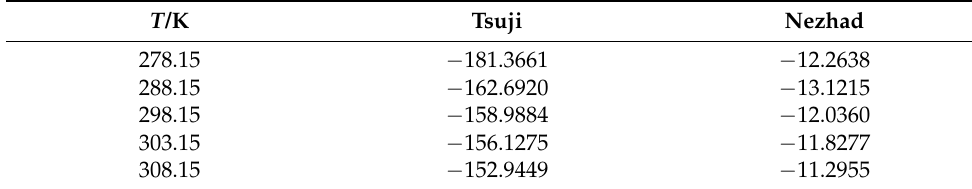
Table 10. Calculation results of AIC value of 7-ADCA correlative solubility and pH model.